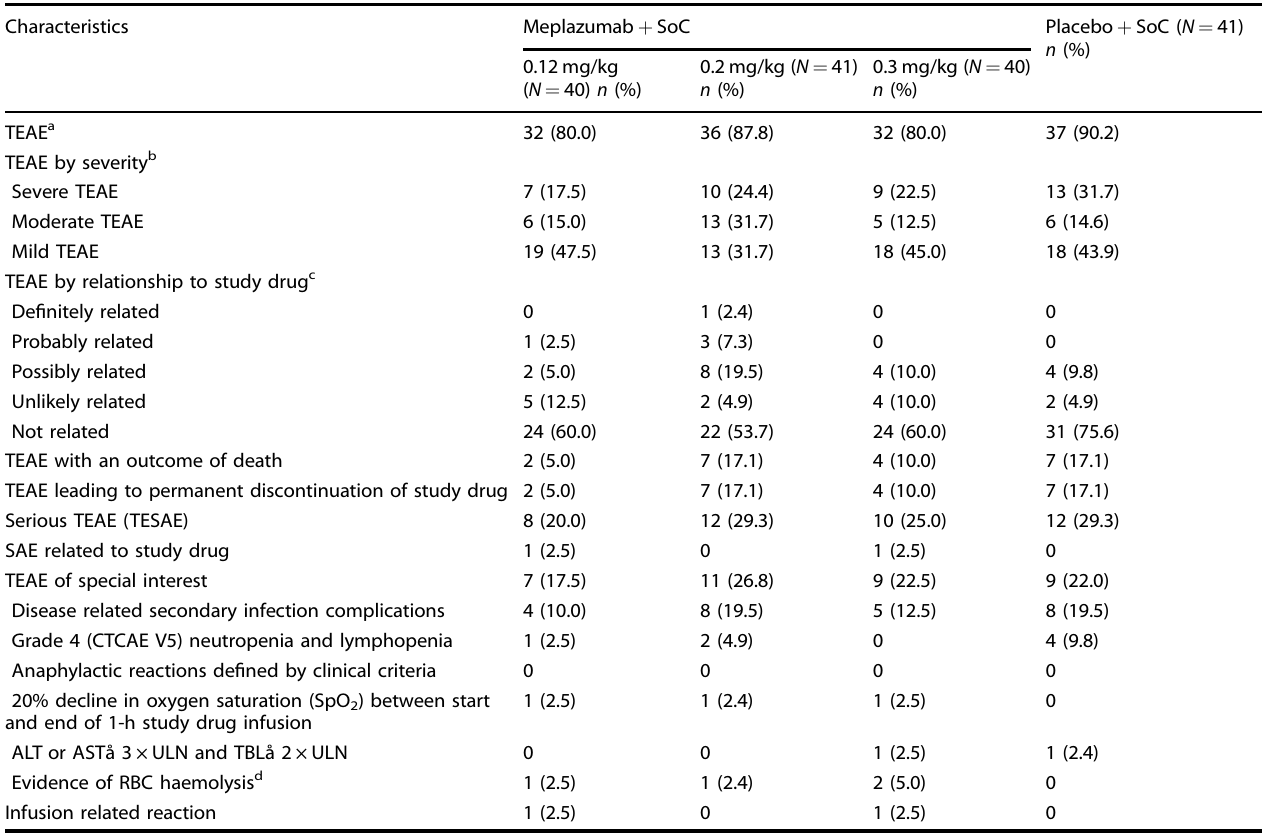
Table 3. Serious adverse events and adverse events of special interest in the safety analysis